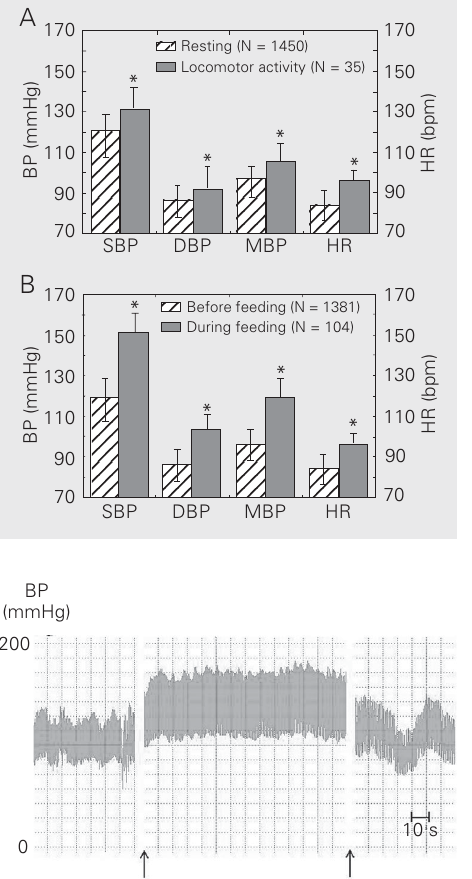
Figure 1. Systolic (SBP), diastolic (DBP) and mean (MBP) blood pressure and heart rate (HR; mean ± SD) of Bradypus varie- gatus at rest and during locomo- tor activity (A) and before and during feeding (B). N = number of measurements. *P < 0.05 compared to the resting condi- tion (Student t -test).